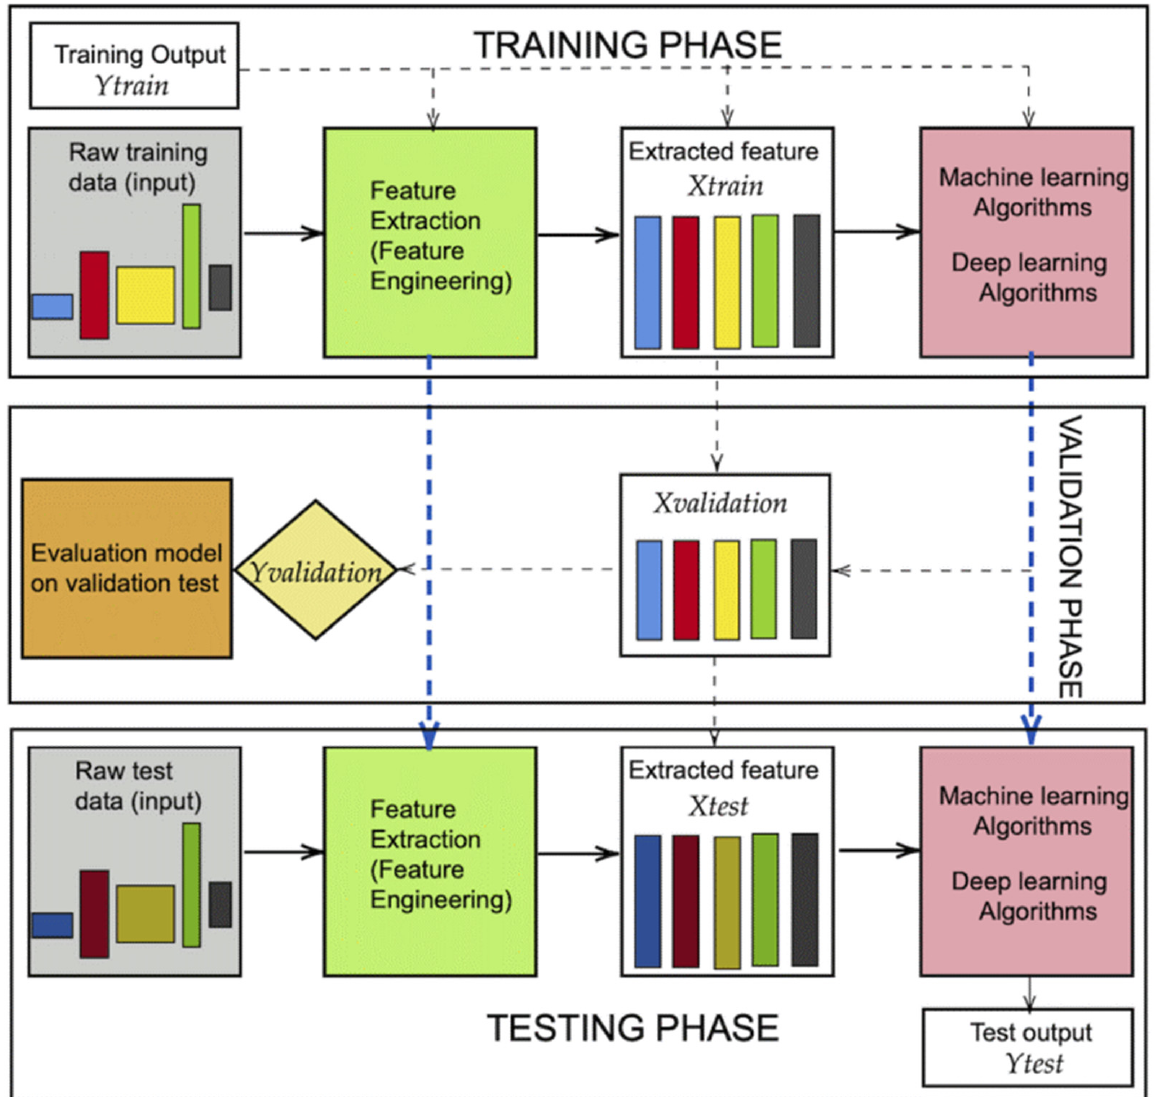
Figure 6. Workflow required for machine algorithms